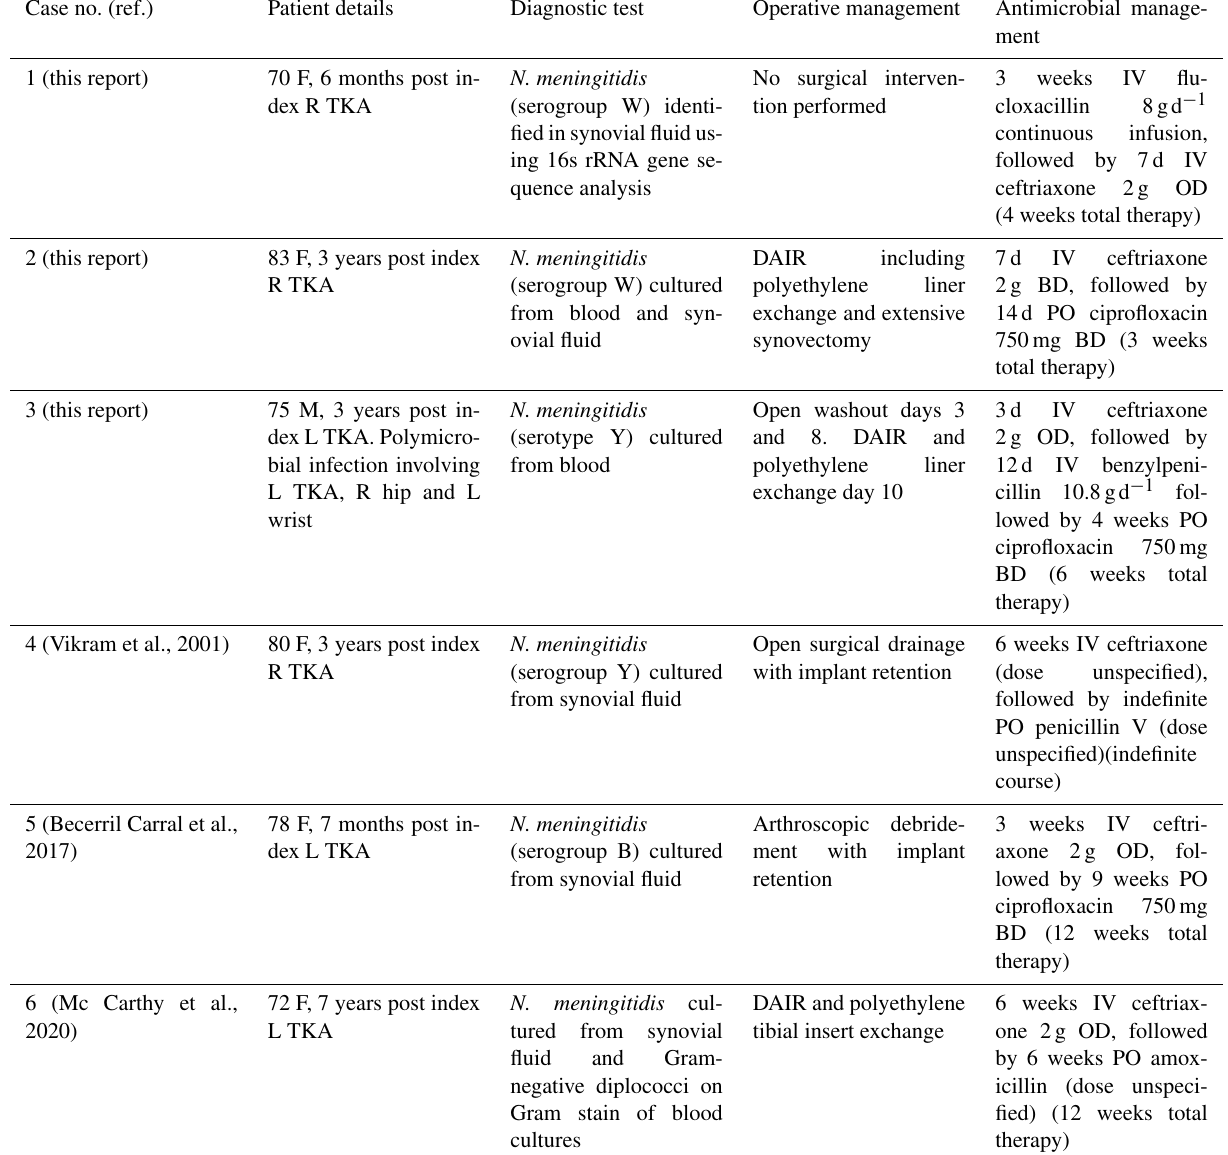
Table 1. Summary of meningococcal prosthetic joint infection case reports. Case no.